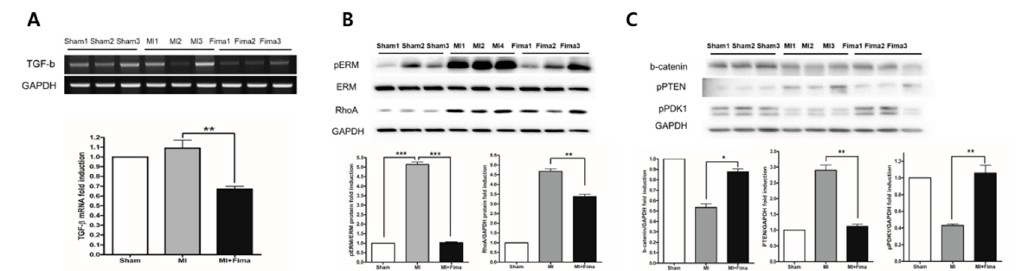
Figure 5. The change in the cardiomyocyte remodeling and survival signaling with fimasartan: ( A ) TGF-beta was significantly decreased in the MI + Fima group. ( B ) The cardiac remodeling regulating molecule ERM and RhoA kinase activity were downregulated in the MI + Fima group. ( C ) The cell survival regulating molecule -catenin, PTEN, and PDK1 activity were upregulated in the MI + Fima group. The P- values represent * P < 0.05, ** P < 0.01, and *** P < 0.001. The results are expressed as mean ± SEM. ERM, Ezrin, Radoxin and Meosin; PTEN, phosphatase and tensin homologue;